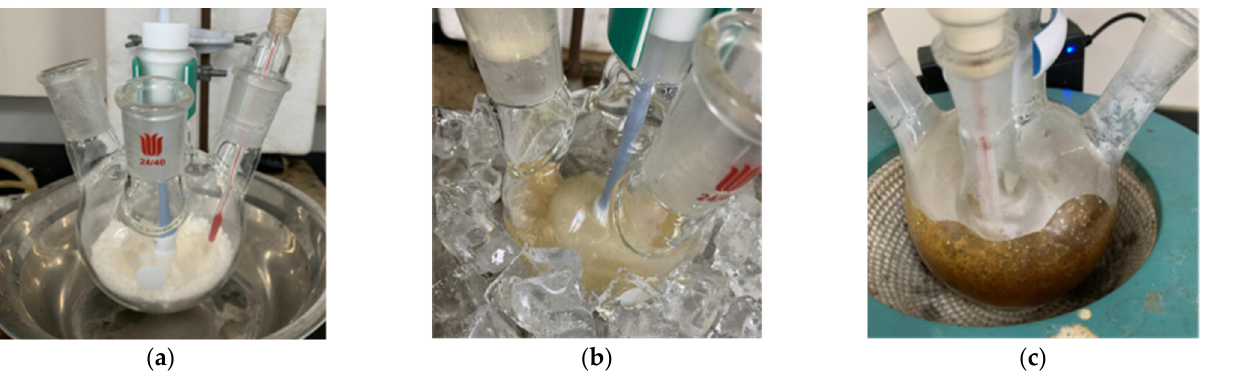
Figure 2. Sulfonation synthesis process 1. ( a ) Propylene diester alginate; ( b ) propylene diester alginate add formamide; ( c ) after dropping chlorosulfonic acid.